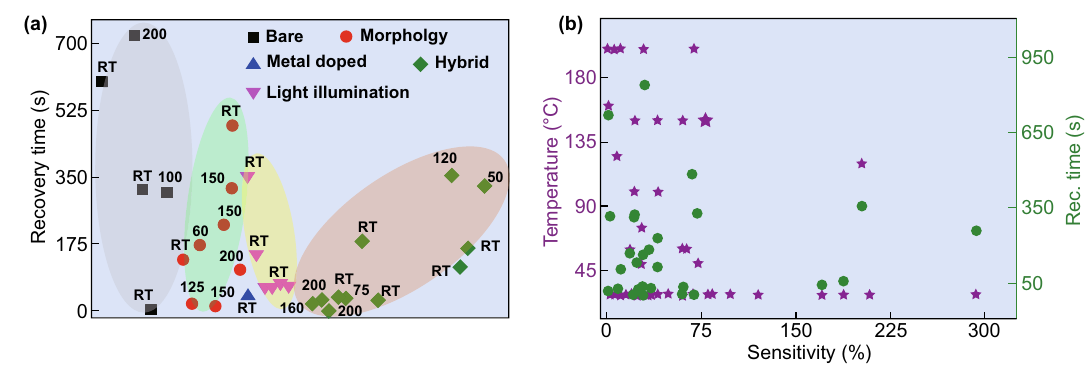
Fig. 23 a Summary of the recovery time obtained through various strategies in MoS 2 . Bare MoS 2 -based NO 2 sensors have highest recovery time followed by the morphology-driven MoS 2 . The light-assisted NO 2 sensors have the lowest recovery time and can operate easily at RT. MoS 2 heterostructure-based sensors have mixed recovery time with different operating temperatures. b MoS 2 -based sensors can operate easily at low temperatures and have low recovery time. Data presented was taken from Refs. [17, 24, 27, 31–36, 118–122, 214, 303–310, 320, 325,